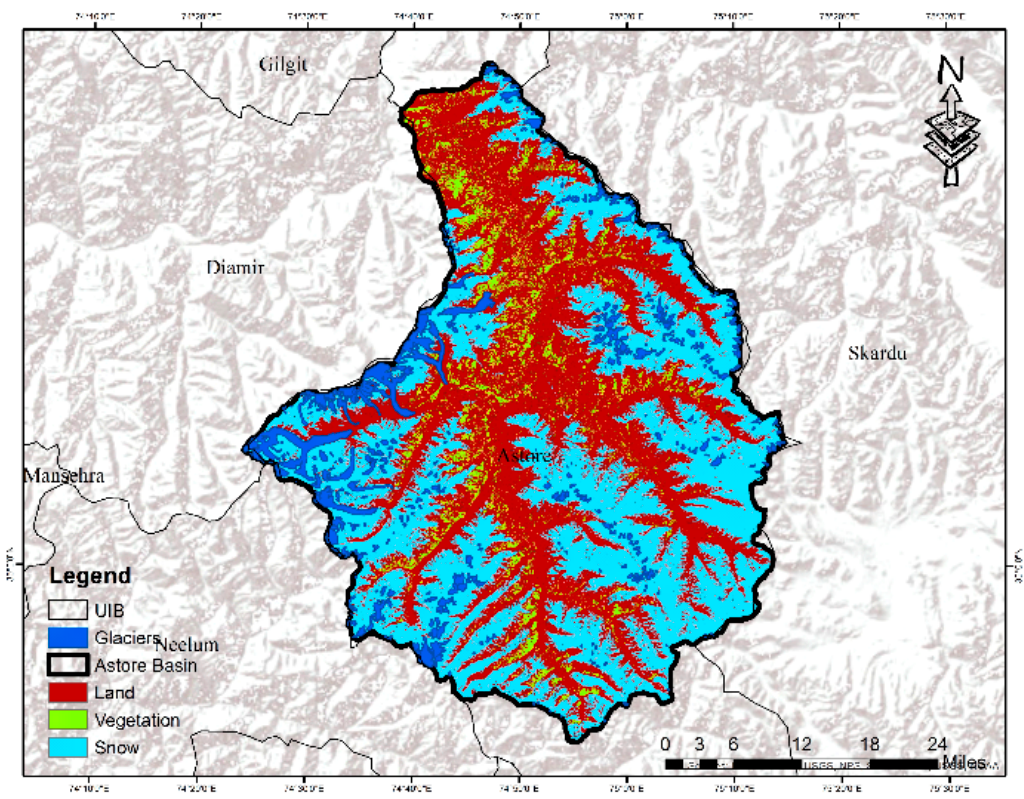
Figure 4. Land cover classified map and glacier boundaries of the Astore basin. Climate 2019 , 7 , x FOR PEER REVIEW